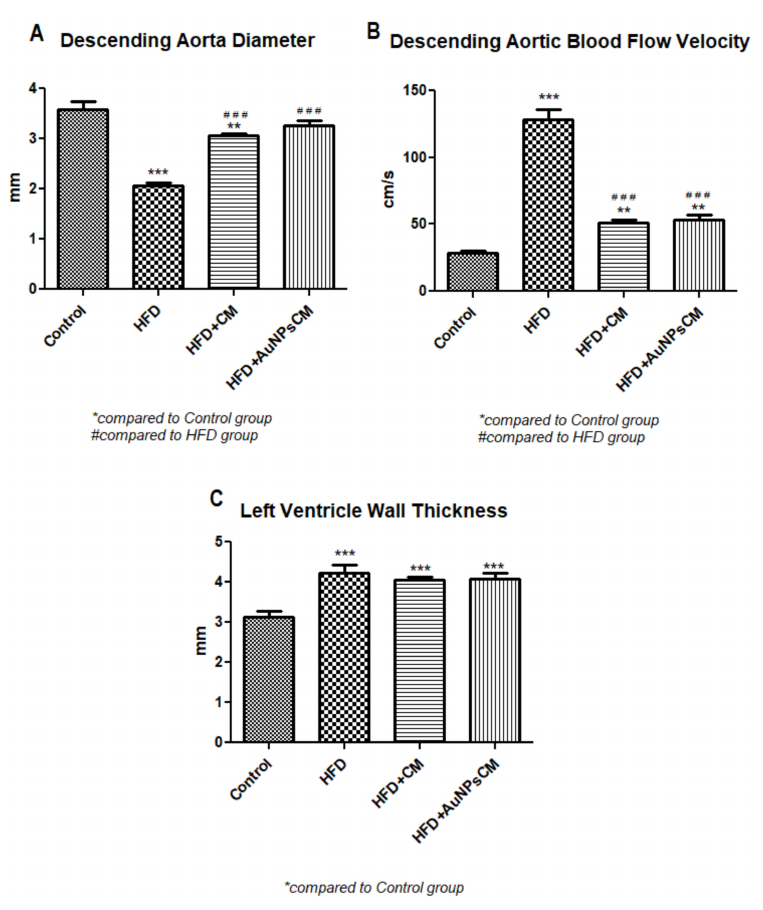
Figure 10. The variations of diameter ( A ) and blood flow velocity ( B ) in the descending aorta and the left ventricle thickness ( C ) modifications in rats with 9 months of HFD, the last month with oral ad- ministration of: 0.9% saline solution for Control and HFD groups, Cornus mas L. extract for HFD + CM group and gold nanoparticles functionalized with bioactive compounds from Cornus mas L. extract for HFD + AuNPsCM group (* compared to Control group, # compared to HFD group). The results were statistically analyzed by one-way ANOVA followed by the Post-test Tukey, using GraphPad Prism version 5.03 software (GraphPad, San Diego, CA, USA). The parameters were expressed as means ± SD (** p < 0.01, *** p < 0.001 compared to Control group; ### p < 0.001 compared to HFD